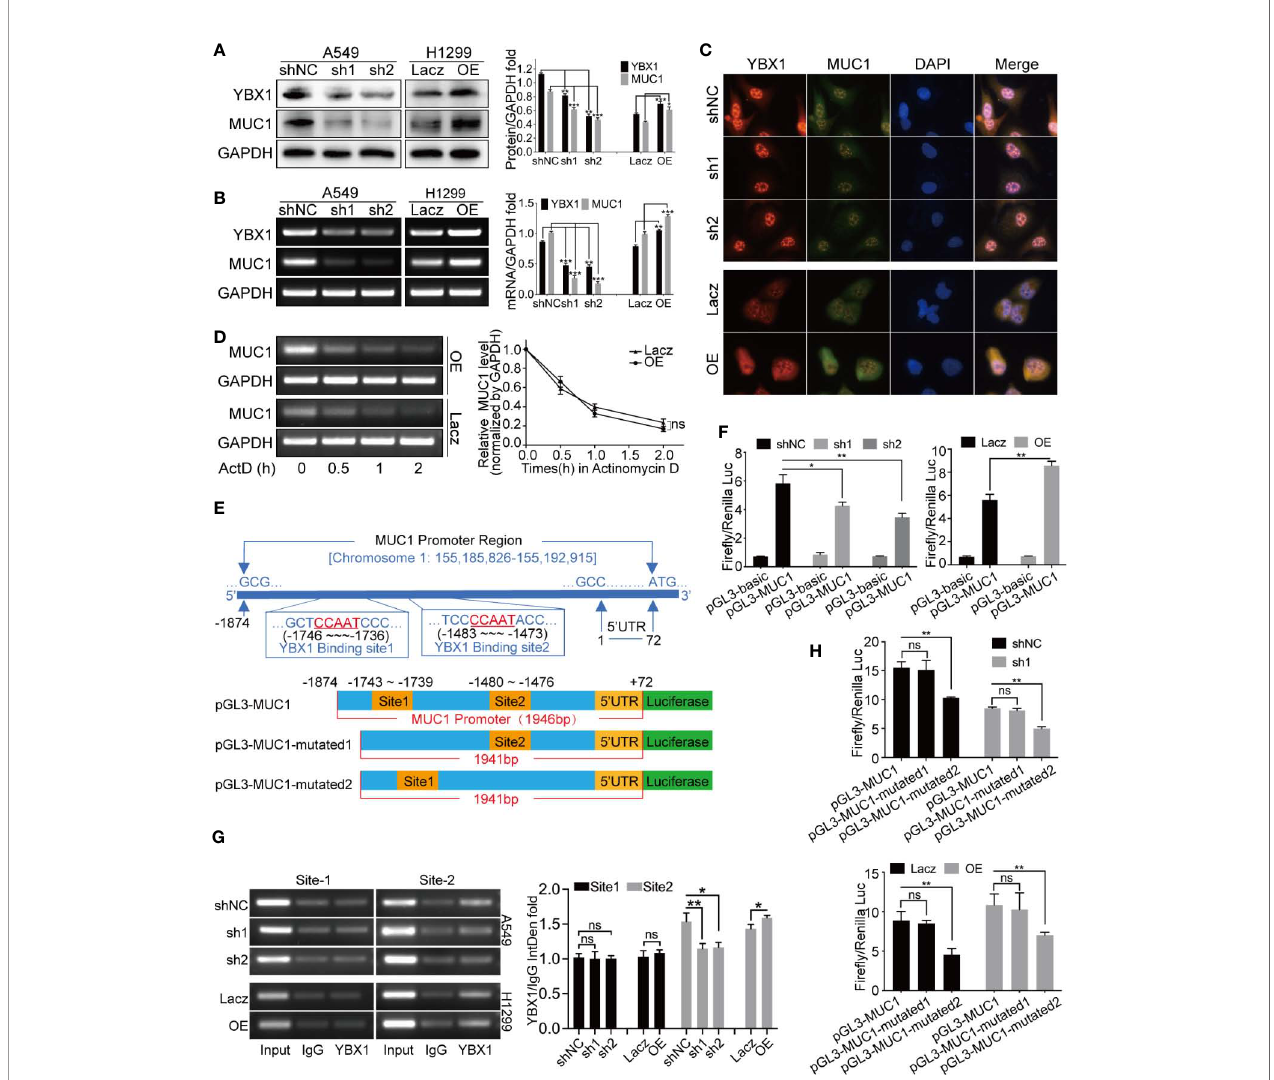
FIGURE 2 | YBX1 affected MUC1 expression through transcriptional regulation. (A) Western blot analysis of YBX1 and MUC1 expression in A549 cells with YBX1 silence (sh1 or sh2), and in H1299 cells with YBX1 overexpression (OE). (B) RT-PCR analysis of YBX1 and MUC1 in A549 cells with YBX1 silence, and in H1299 cells with YBX1 overexpression. (C) The YBX1 and MUC1 expression and the YBX1 nuclear translocation were detected by immuno fl uorescence assay, after silencing YBX1 in A549 or overexpression of YBX1 in H1299. (D) Actinomycin-D transcription repression assay showed that the stability of MUC1 mRNA did not change signi fi cantly after YBX1 overexpression. (E) The location of two putative YBX1 binding sites in the MUC1 promoter region, and three plasmids required for the dual-luciferase reporter assay. (F) The dual-luciferase assay showed that the promoter region of MUC1 was positively activated by YBX1. (G) The ChIP assay found the binding of YBX1 was at putative site 2, and the activation was affected by YBX1 expression. (H) The dual-luciferase activity was signi fi cantly reduced after mutating site 2, compared with mutating site 1, and affected by YBX1 expression. The data are presented as mean ± SD of three independent tests. *P < 0.05, **P < 0.01, ***P < 0.001. ns, non-signi fi